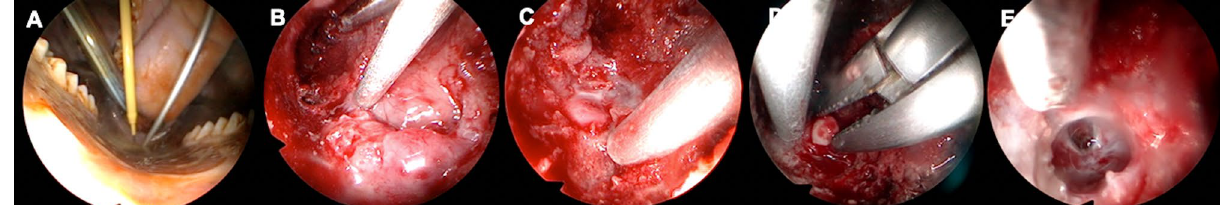
Figure 2. Endoscopic finding during the operation. Soft palate ( A ), drilling of the sphenoid bone ( B ), dura on the sella ( C ), pituitary gland ( D ), and space after the pituitary gland removal ( E ).